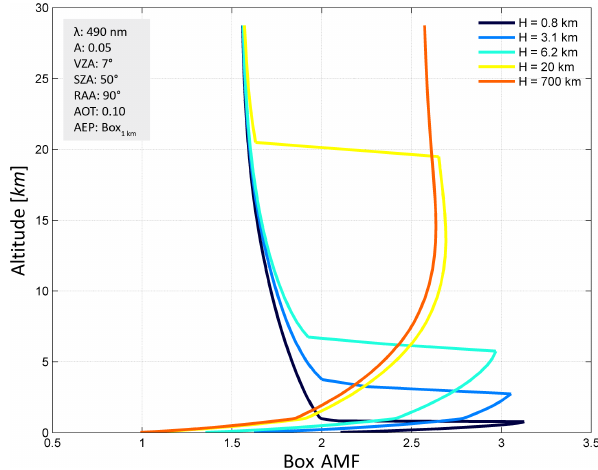
Figure 8. Height-dependent box AMFs assessing the vertical sen- sitivity to NO 2 , illustrated for five different scenarios for the sensor altitude H , in kilometres above ground